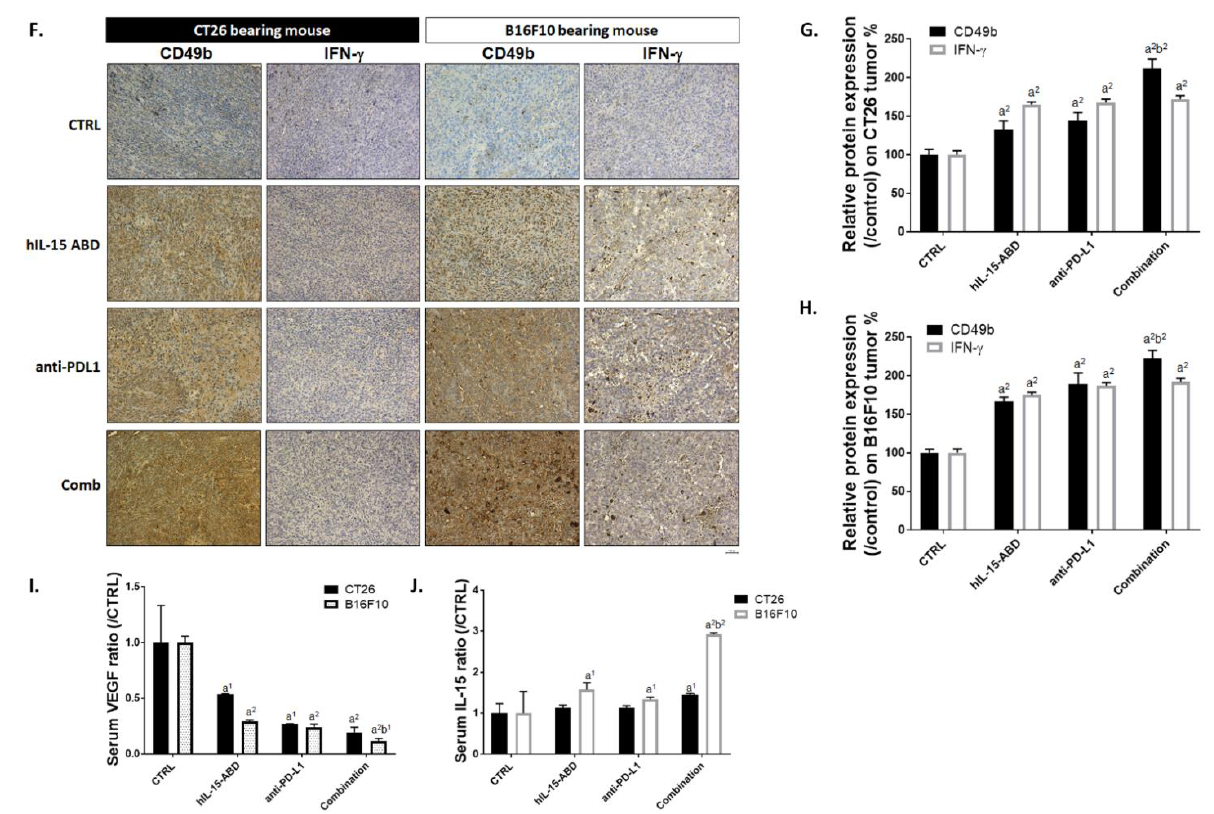
Figure 6. hIP-15-ABD combined anti-PD-L1 antibody effectively trigger the accumulation and function of NK cells. ( A ) Flow cytometry pattern and ( B ) quantification results of CD3 - /CD49b + , CD3 - /CD335 + and CD3 - /CD49b + /CD335 + NK cells from SP on CC bearing BALB/c animal model. ( C ) Quantification results of CD3 - /CD49b + , CD3 - /NK1.1 + and CD3 - /CD49b + /NK1.1 + NK cells from SP on melanoma bearing C57BL/6 animal model. ( D , E ) CD3 - /CD335 + /IFN-γ + and CD3- /NK1.1 + /IFN-γ + NK cells from SP on CC and melanoma model is displayed. ( F ) CD49b and IFN-γ IHC staining images and relative proteins quantification level on ( G ) CC and ( H ) melanoma are shown. Expression level of secreted ( I) VEGF and ( J ) IL15 are shown as quantification results. (a 1 p < 0.05, a 2 p < 0.01 vs. CTRL; b 1 p < 0.05, b 2 p < 0.01 vs. hIL15-ABD and anti-PD-L1; scale bar = 100 μm).